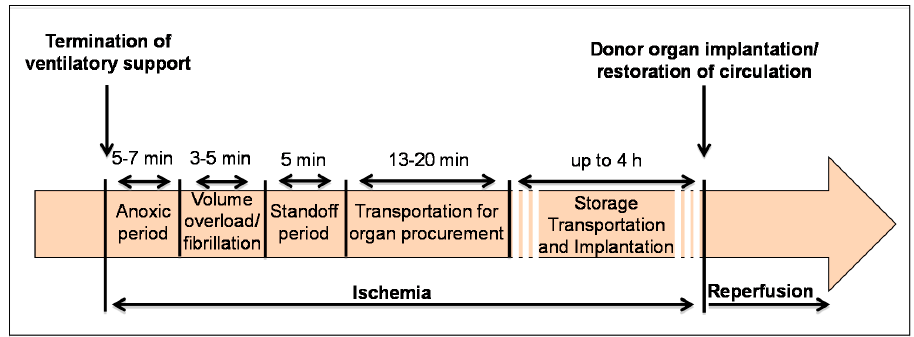
Figure 2. Steps and timing of the donation after cardiac death protocol (DCD). This timeline is based on the standard DCD organ procurement protocol and incorporates the timing for storage, transportation and implantation that are applied to the Donation after Brain Death heart. The DCD heart becomes ischemic starting from the termination of ventilator support and ensuing anoxia. Initial ischemia occurs in the donor (warm ischemia) and lasts approximately between 25 and 35 min. The storage and transportation may increase the time of ischemia (cold ischemia during storage and preservation) for an additional 4 h. With the heart transplantation and the restoration of the circulation, the donor’s heart is reperfused within the recipient’s circulation.